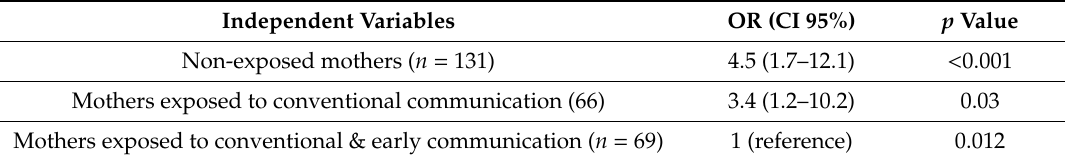
Table 4. Results of multivariable logistic regression model: variables significantly associated with vaccine hesitancy attitude.